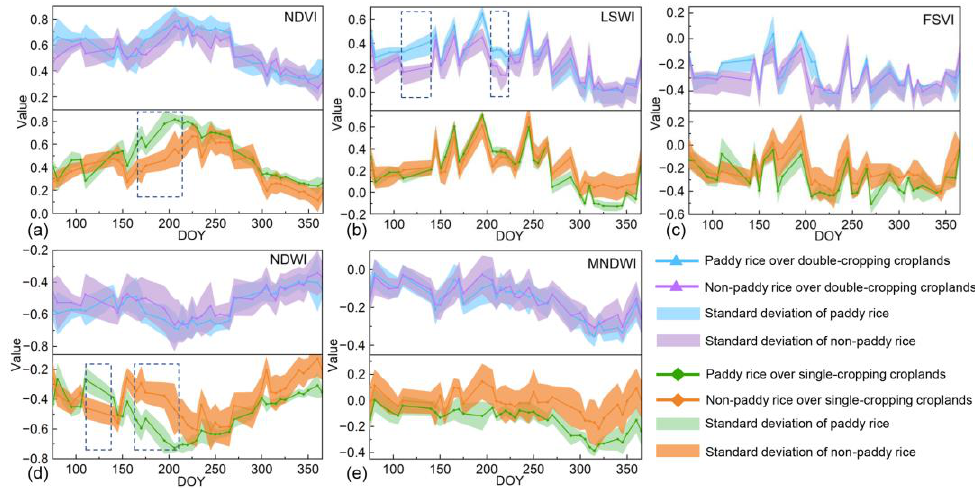
Figure 7. Temporal trajectories of ( a ) NDVI, ( b ) LSWI, ( c ) FSVI, ( d ) NDWI, and ( e ) MNDWI for paddy rice and non-paddy rice over double- (upper panel) and single-cropping (lower panel) croplands. The lines and filled areas represent the VI means and standard deviations for the training samples. The dotted square exhibited the significant VI separability between two crop types.